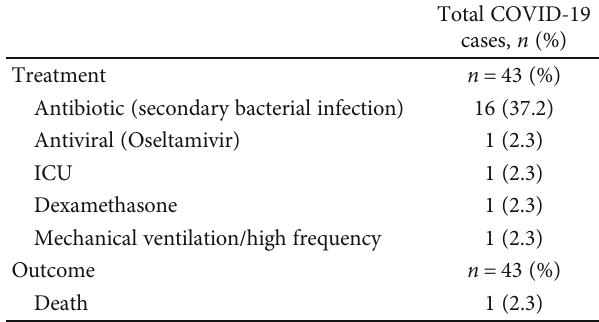
Table 4: Patient